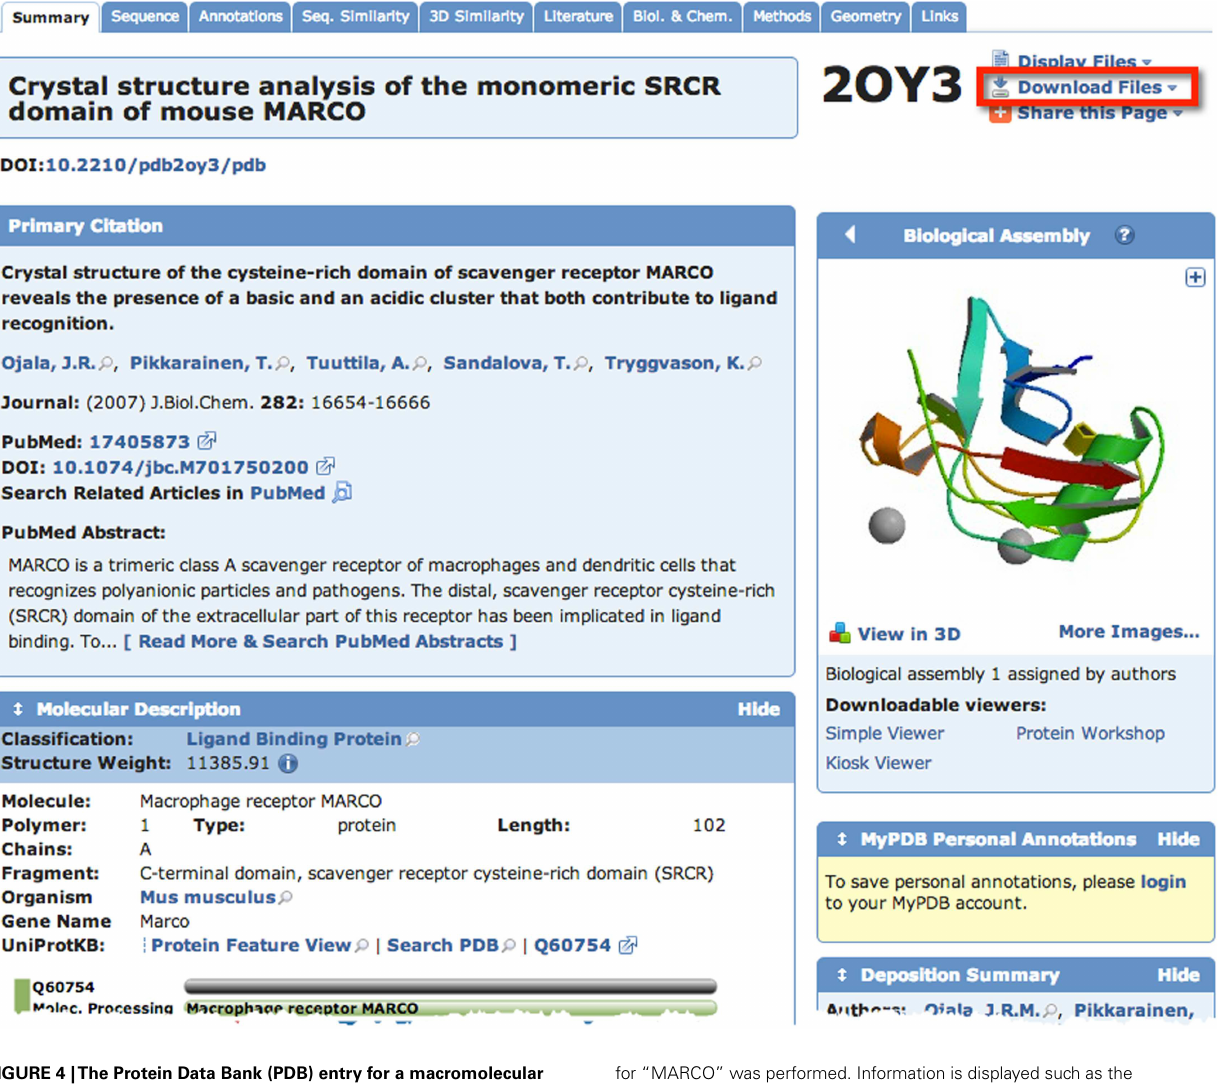
for “MARCO” was performed. Information is displayed such as the primary citation from which this structure was submitted, and a small visualization of the structure. Further, more detailed visualizations can be created easily by the user by downloading the .pdb formatted file from the top right of an entry, and displaying it in software such as UCSF